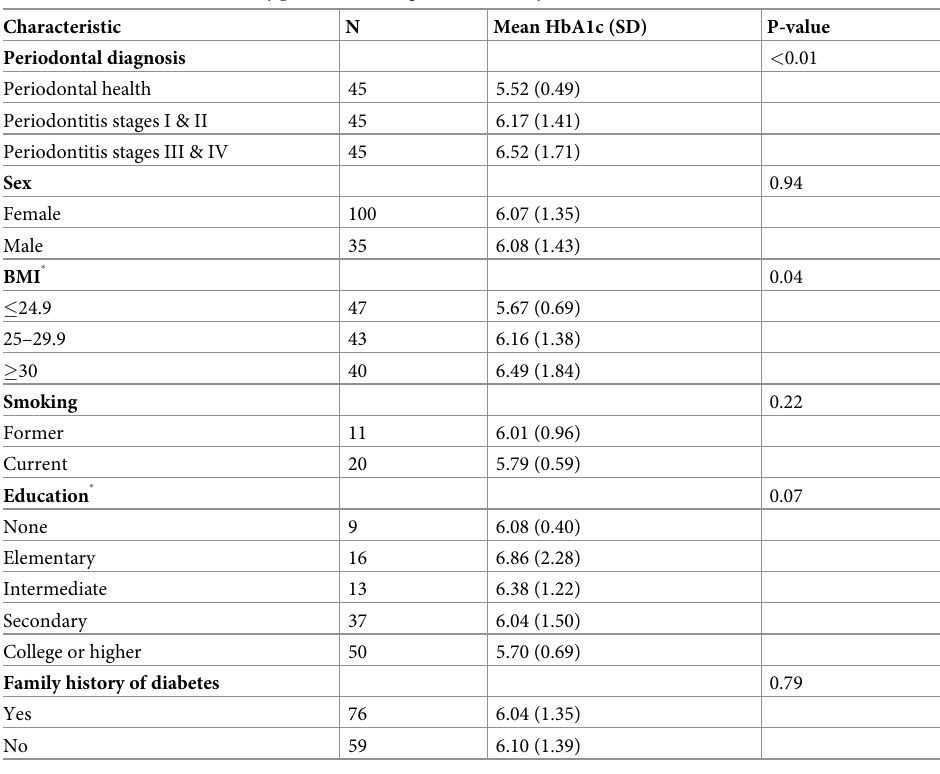
Table 2. Mean HbA1c and SD by periodontal diagnosis and study covariates. Characteristic N Mean HbA1c